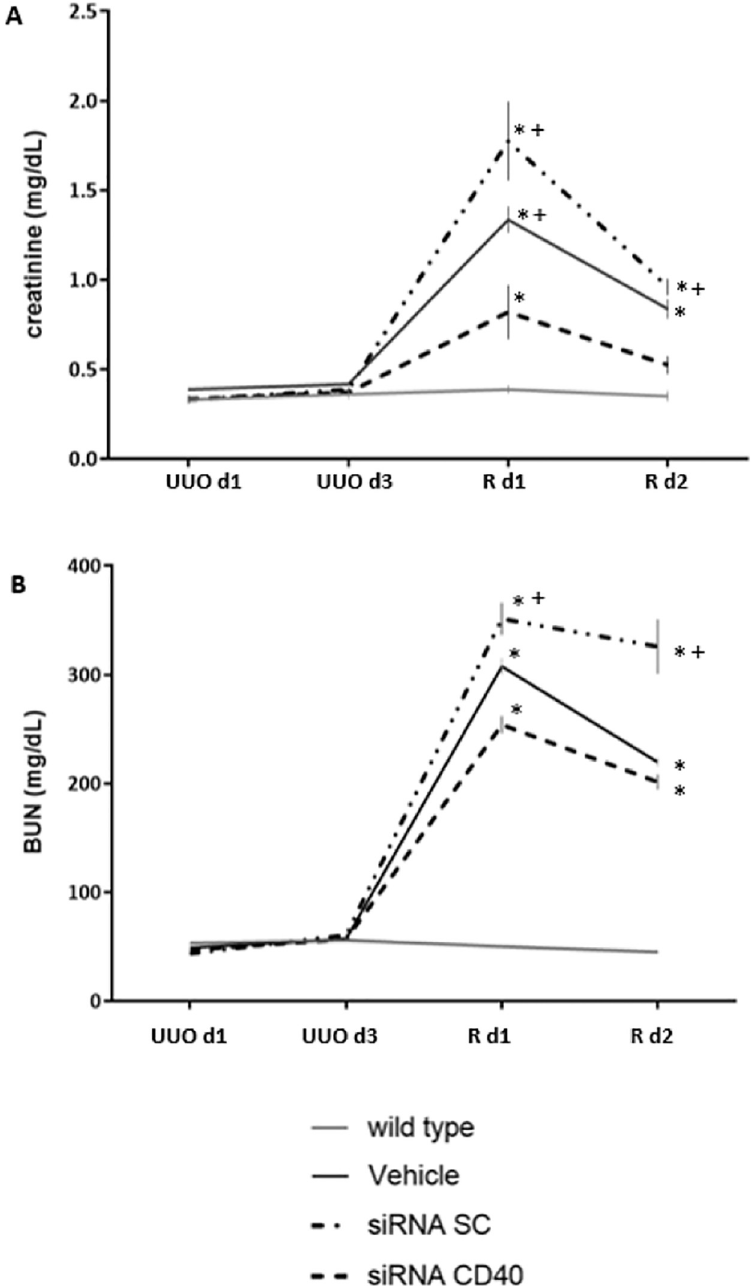
Fig 2. Renal Function analysis. (A) Creatinine and (B) Blood Urea Nitrogen (BUN) analysis. In all groups, both creatinine and BUN levels significantly increased showing maximum values at day 1 post clamp release (D-UUO d1) compared to the non-treated animals (WT). siRNA-CD40 treated group showed lower levels of creatinine and BUN reflecting a fast recovery of the renal function. ANOVA test; data are means ± SE, � p � 0.05 vs WT, + p � 0.05 vs